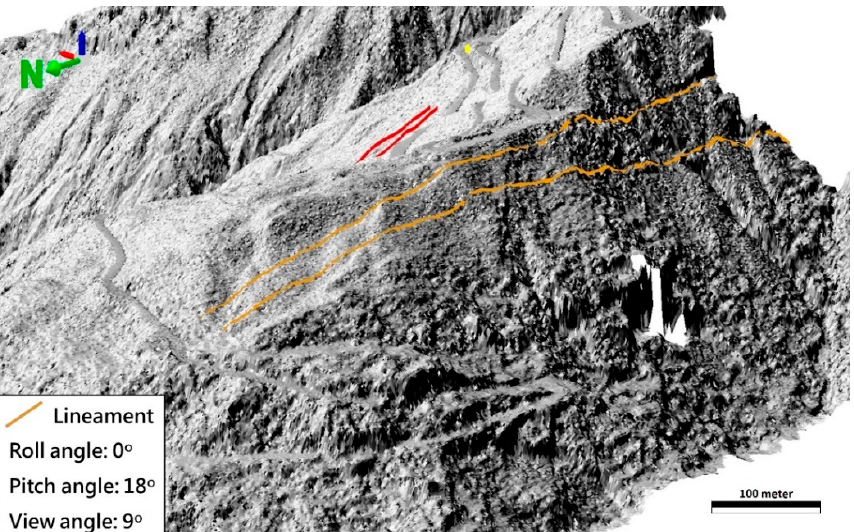
Figure 10. The three-dimensional shaded relief map derived from DTMH viewing from east direc- tion toward west direction. Two lineaments were identified and marked by the red lines, the yellow dots marked the out-crop field investigation points A, B, C, and D.